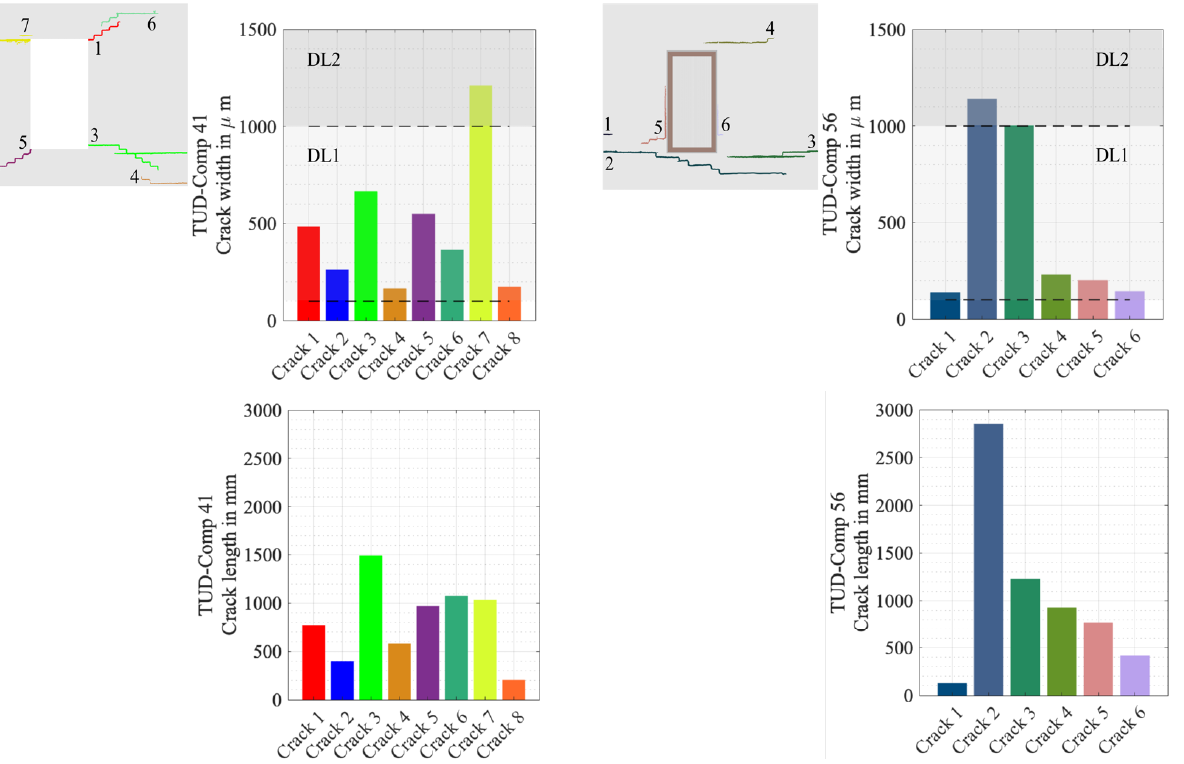
Figure 14. Performance during the SLS phase in terms of crack width and length.